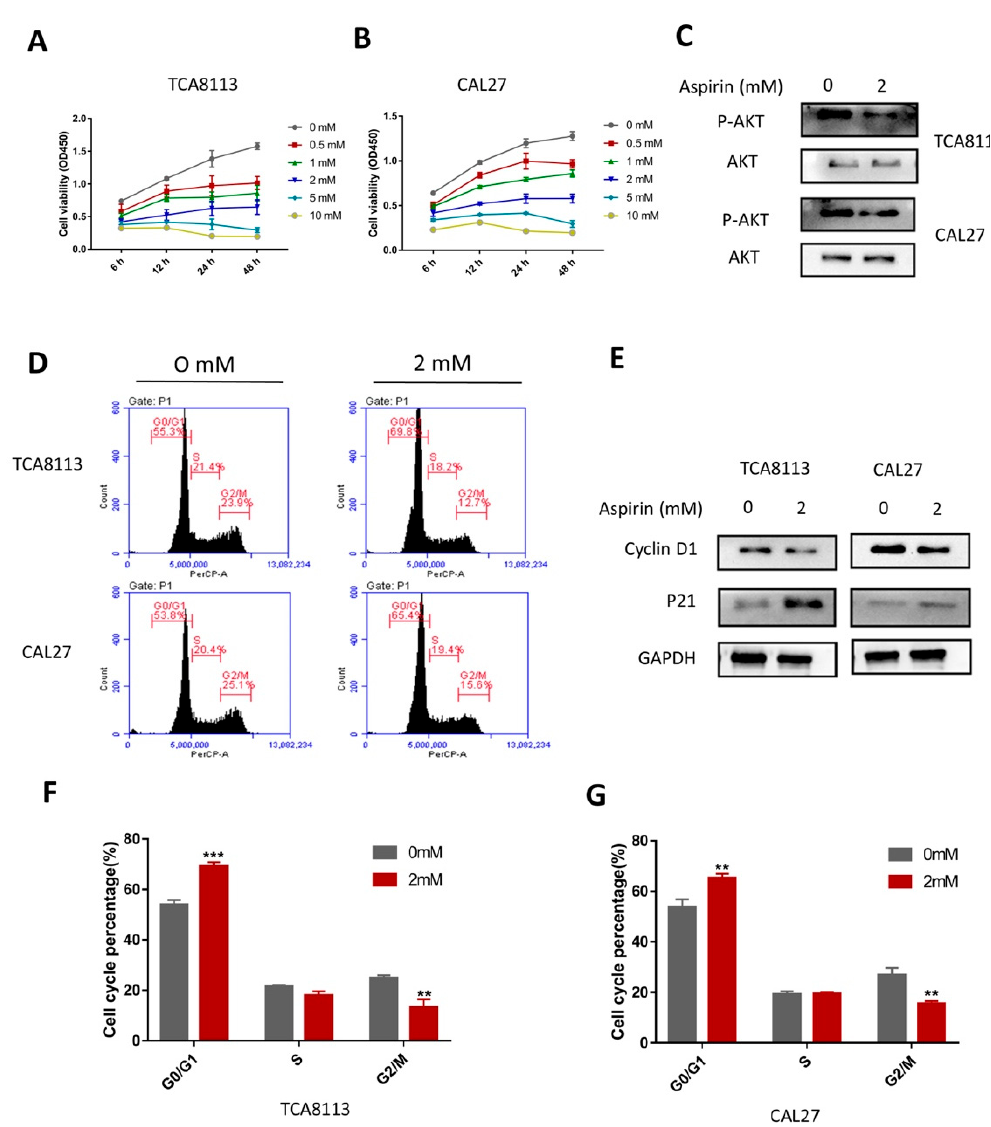
Figure 3. Aspirin inhibited cell viability and promoted cell cycle G0/G1 phase arrest. ( A , B ) Aspirin (ASA) inhibited cell viability in dose- and time-dependent manner. The TCA8113 and CAL27 cells were treated with different concentrations of aspirin for the indicated times, and the viability of these cells was measured using CCK8 assays. ( C ) The ASA treatment affected the phosphorylation of Akt in TCA8113 and CAL27 cells. Western blotting was used to detect the expression and phosphorylation of Akt with ASA treatment. ( D – G ) The cell cycle was arrested in the G1 phase with ASA treatment the in TCA8113 and CAL27 cells. Flow cytometry was used to analyze the effects of ASA on the cell cycle when cells were treated with or without ASA for 24 h. ( E ) ASA promoted the expression of p21 and decreased the expression of cyclin D1 in the TCA8113 and CAL27 cells. After the cells were incubated with 2 mM ASA for 24 h, the protein levels were detected by Western blotting using indicated antibodies, and GAPDH was used as a loading control. ** p < 0.01 and *** p < 0.005. The data were presented as the mean ± standard deviation (SD) ( n = 3).